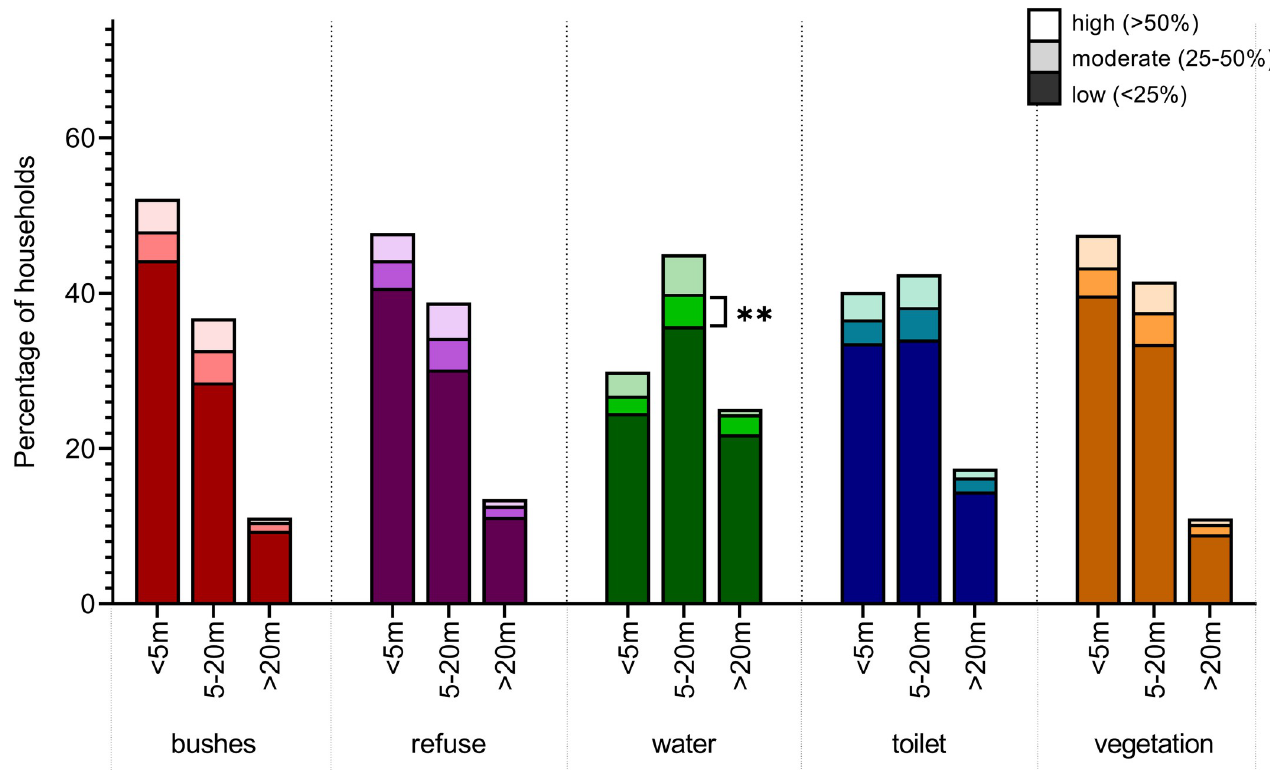
Fig 5. Percentage of households’ proximity to environmental factors, comparing household level LASV IgG seroprevalence (n = 903). The distance of the household to the bushes or wild land, the garbage pits or refuse pile for the household, the household’s main water source, the household’s main toilet facility, and the household’s farmland or cultivated vegetation was measured in meters by a LFOT fieldworker. Each household was categorized by the percentage of their seroprevalence. Households with more than 50% seroprevalence were categorized as high. Households with 25–50% were moderate and households less than 25% were low. The likelihood of a household having greater than 50% seroprevalence was determined in a multivariate analysis.